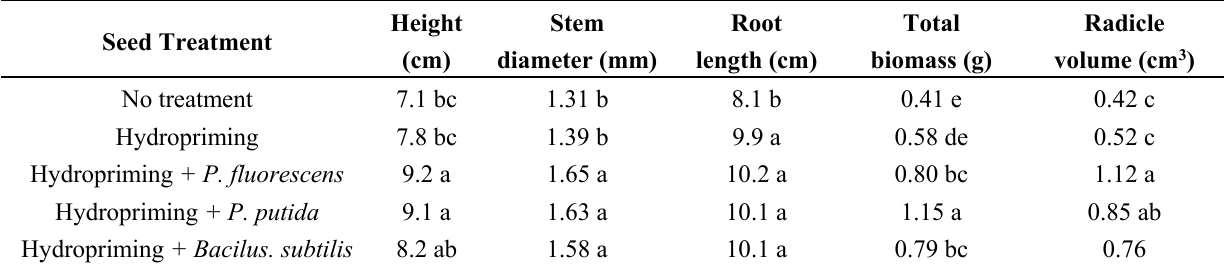
Table 1 . Measurement of growth parameters of Abies hickelii (only) ǂ with hydropriming and biopriming